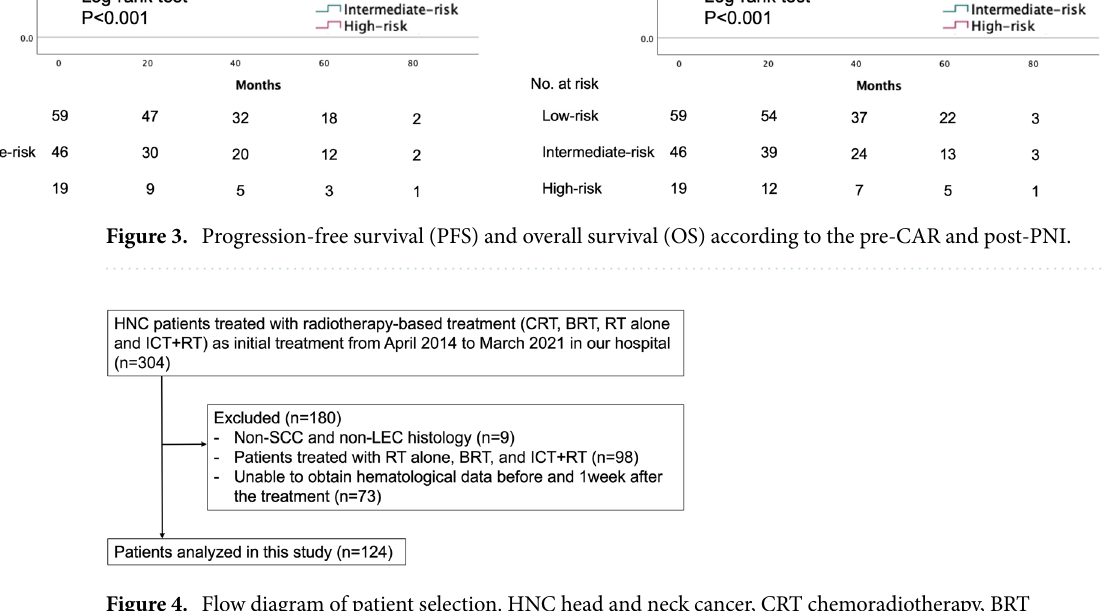
Figure 4. Flow diagram of patient selection. HNC head and neck cancer, CRT chemoradiotherapy, BRT bioradiotherapy; RT radiotherapy, ICT induction chemotherapy, SCC squamous cell carcinoma, LEC lymphoepithelial